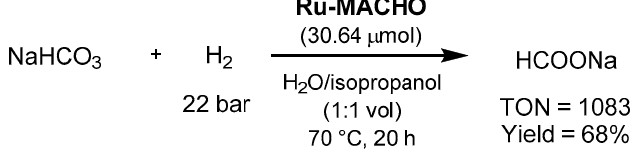
Figure 6. Ru-NNN pincer complexes synthetized and characterized by Peng and Zhang [648]. Kirchner and Gonsalvi reported in 2017 the use of Mn(I) pincer complexes for CO 2 hydrogenation to formate [649]. In this example, the hydride Mn(I) catalyst [Mn( iPr PNP NH )(H)(CO) 2 ] 69 was employed and showed higher stability and activity than its Fe(II) analogue. Thus, using 10 μ mol of catalyst 69 , at 80 °C, for 24 h, and 80 bar total pressure (1:1 H 2 /CO 2 ) in THF/H 2 O, and in the presence of DBU as base and LiOTf as the co-catalyst, TONs up to 10,000 and yield up to >99% were achieved (Scheme 72). Decreasing the catalyst loading to 0.002 mol%, resulted in TONs up to 30,000. Importantly, the system is active already at room temperature, and remains active for up to 48 h (TON = 26,600) with an average TOF of approximately 550 h − 1 indicating a constant rate of reaction. Scheme 72. CO 2 hydrogenation to formate catalyzed by Mn complex 69 reported by Kirchner and Gonsalvi [649].